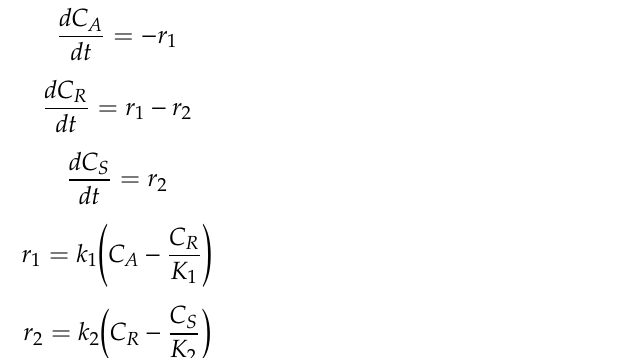
Figure 1. Consecutive reaction system.